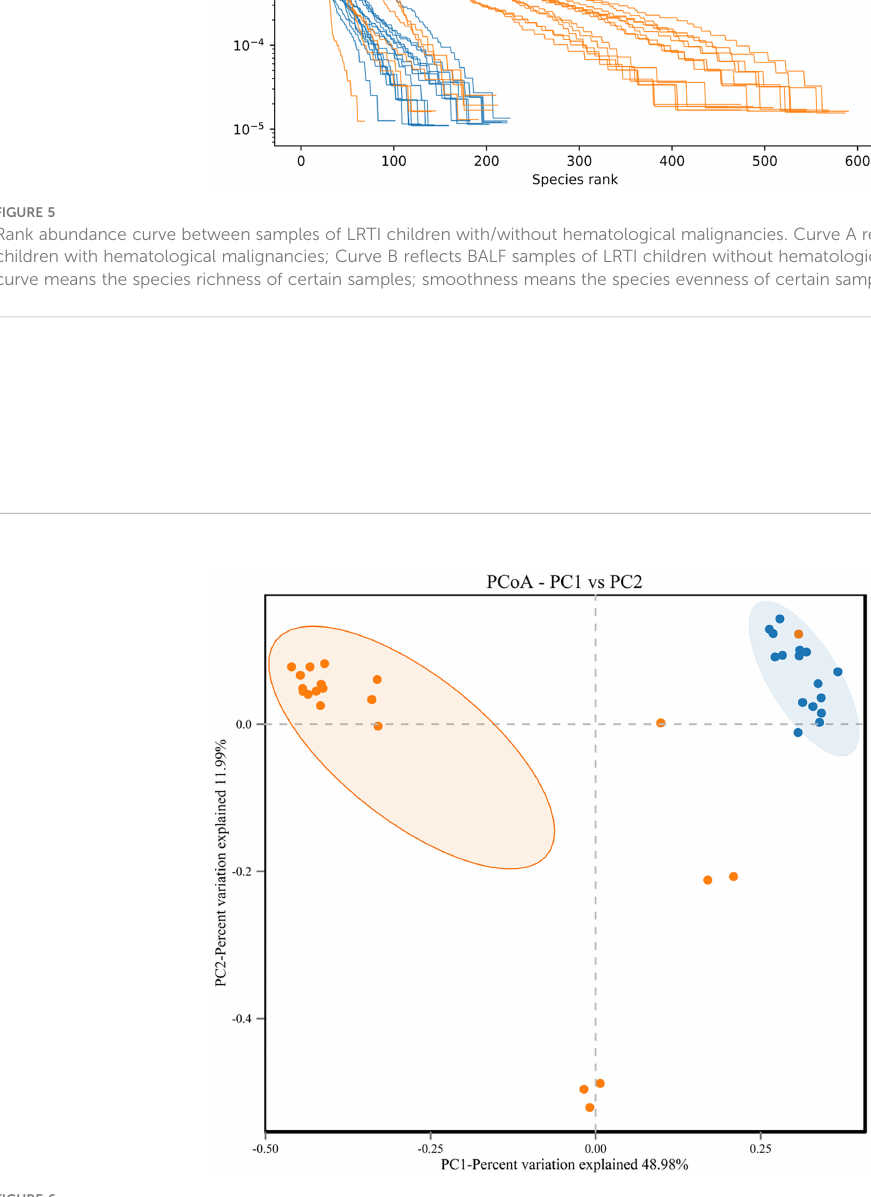
FIGURE 6 Principal Co-ordinates Analysis (PCoA) of samples of LRTI children with/without hematological malignancies. Dots A re fl ect BALF samples ofLRTI children with hematological malignancies; Dots B re fl ect BALF samples of LRTI children without hematological malignancies.